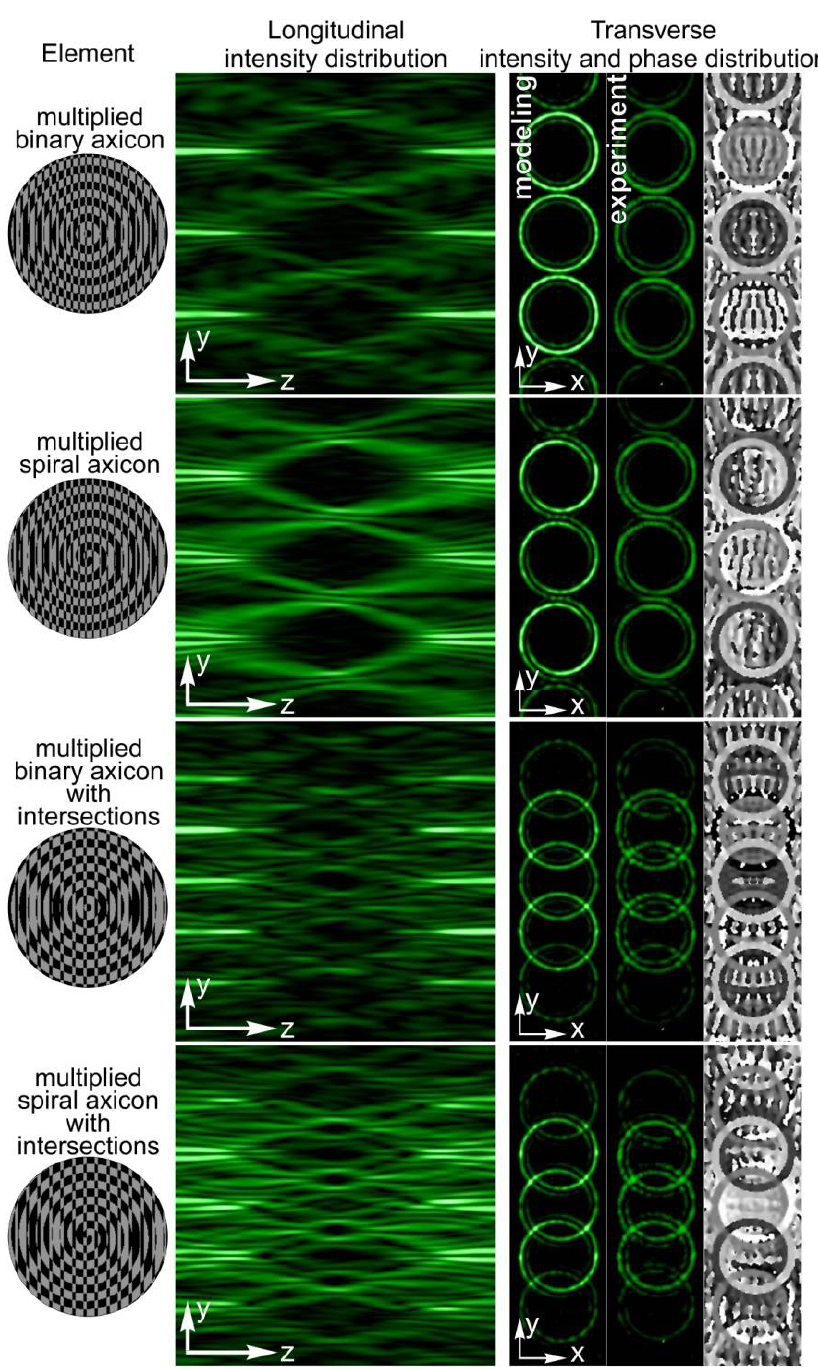
Figure 7. The examples of multiple vector optical bottles generated using different multiplied axicons illuminated by a circularly polarized Gaussian beam.